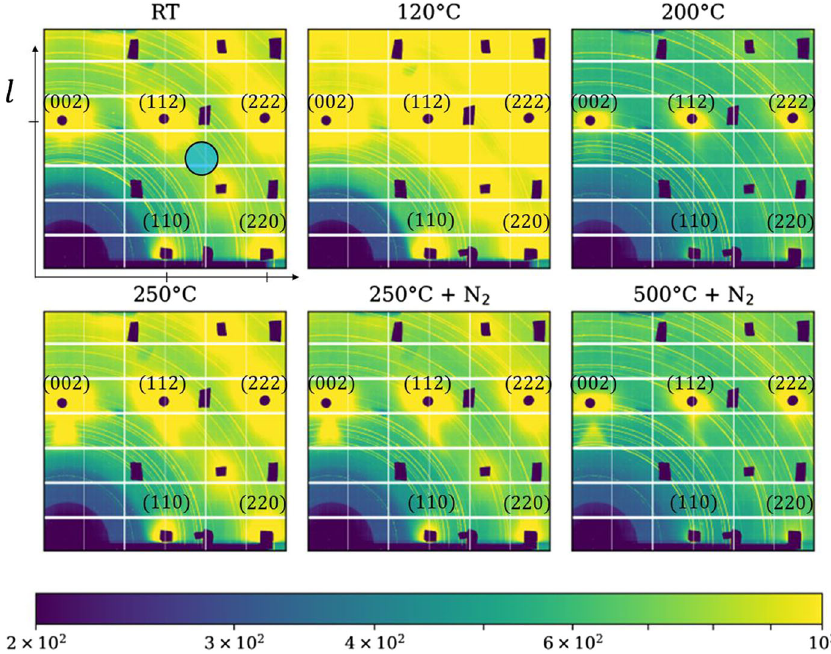
FIG. 6. Diffraction patterns obtained at different temperatures with an incident angle of 0.04°, corresponding to a scattering depth Λ of ∼ 100 nm. At 120 °C, a clear increase in diffuse intensity is observed due to the presence of subsurface oxygen. Lead (Pb) pieces block the Nb Bragg peaks. Powder rings originating from the beryllium (Be) windows of the chamber are also observed. The region of interest employed in the data analysis is schematically shown in blue (see the text for